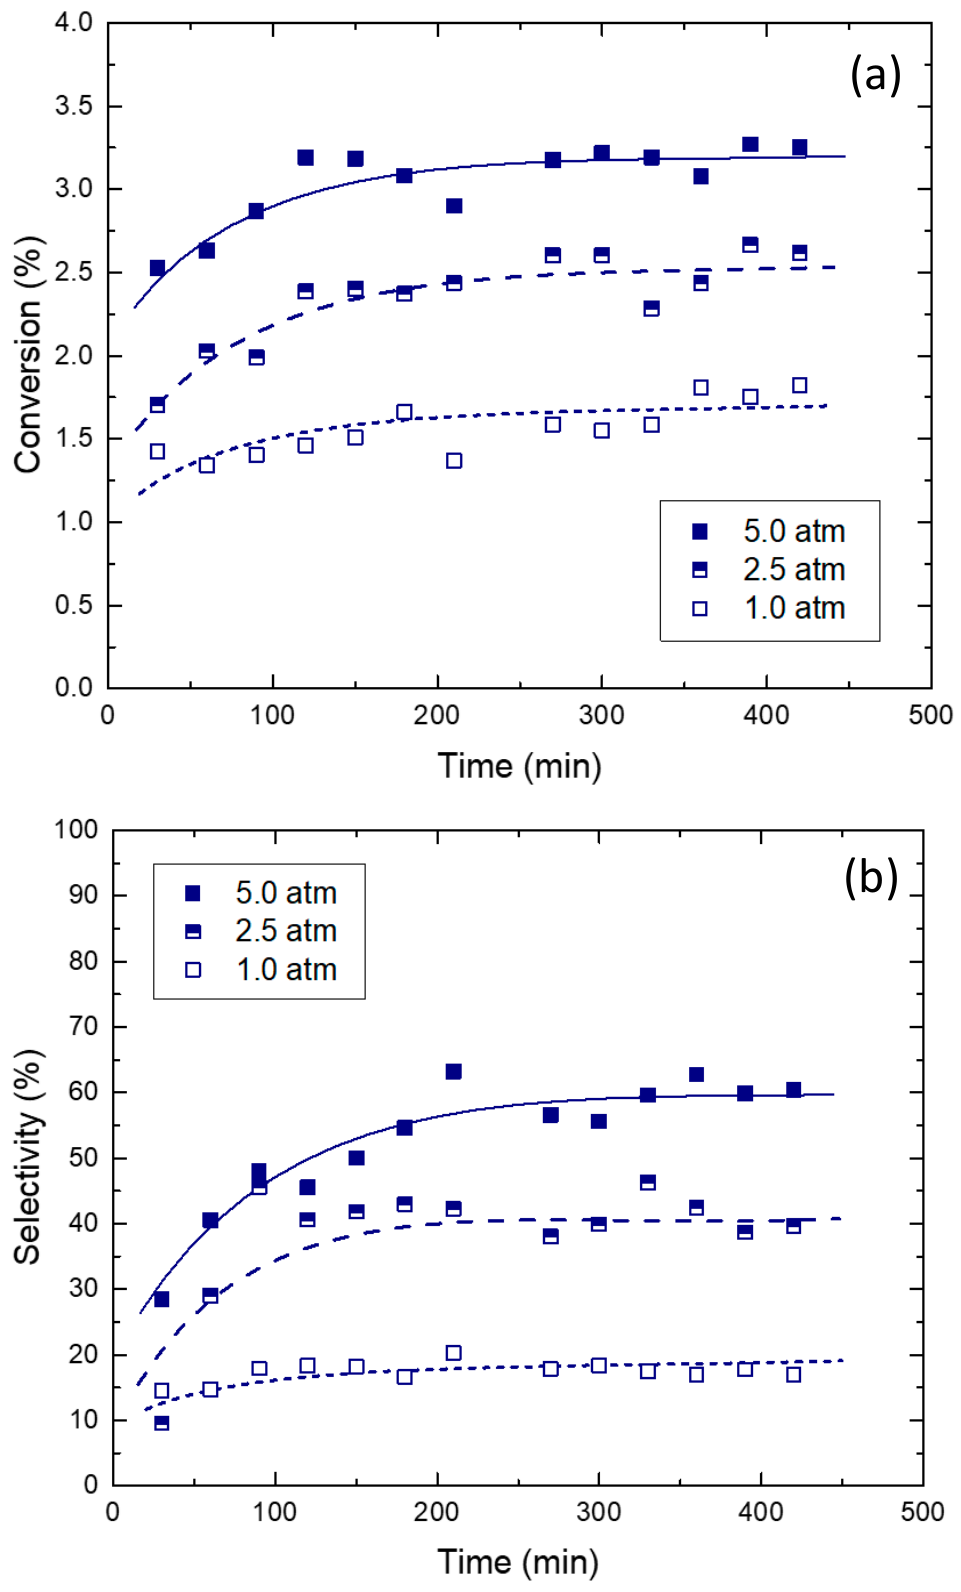
Figure 6. ( a ) Conversion and ( b ) selectivity for CZA-30 ́ at 210 °C.